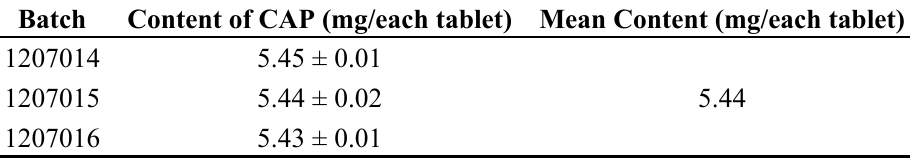
Table 4. Content of CAP (means ± SD, n =